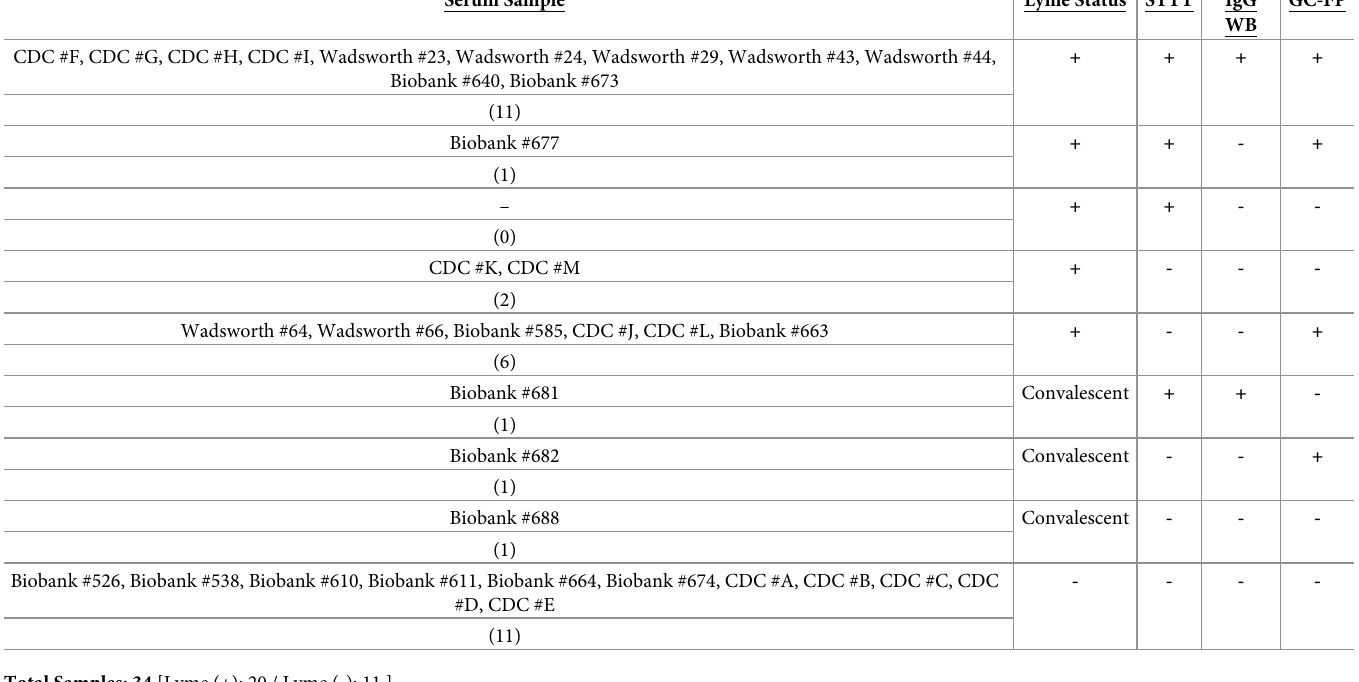
Table 4. Comparison of GC-FP biochip with STTT results. GC-FP results based on our diagnostic test were compared with STTT results and the standard IgG Western blot results. The total number of serum samples in each group and subgroup is also reported. Serum